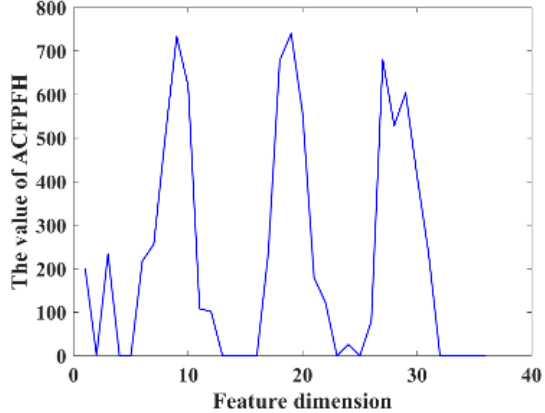
Figure 6. The ACFPFH of one point.